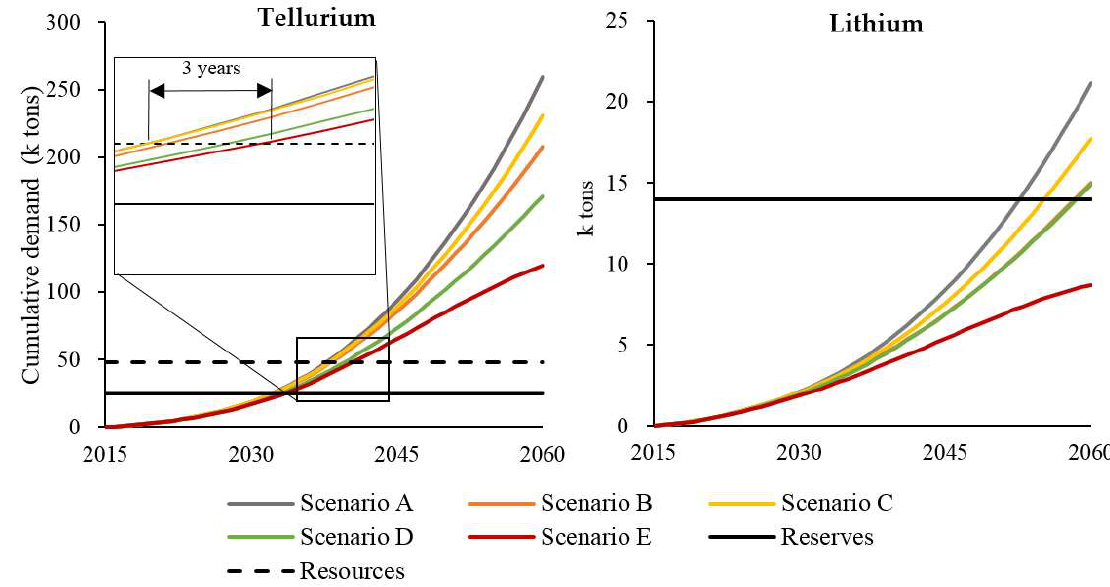
Figure 18. Cumulative primary demand from 2016 to 2060 considering recycling and reducing.